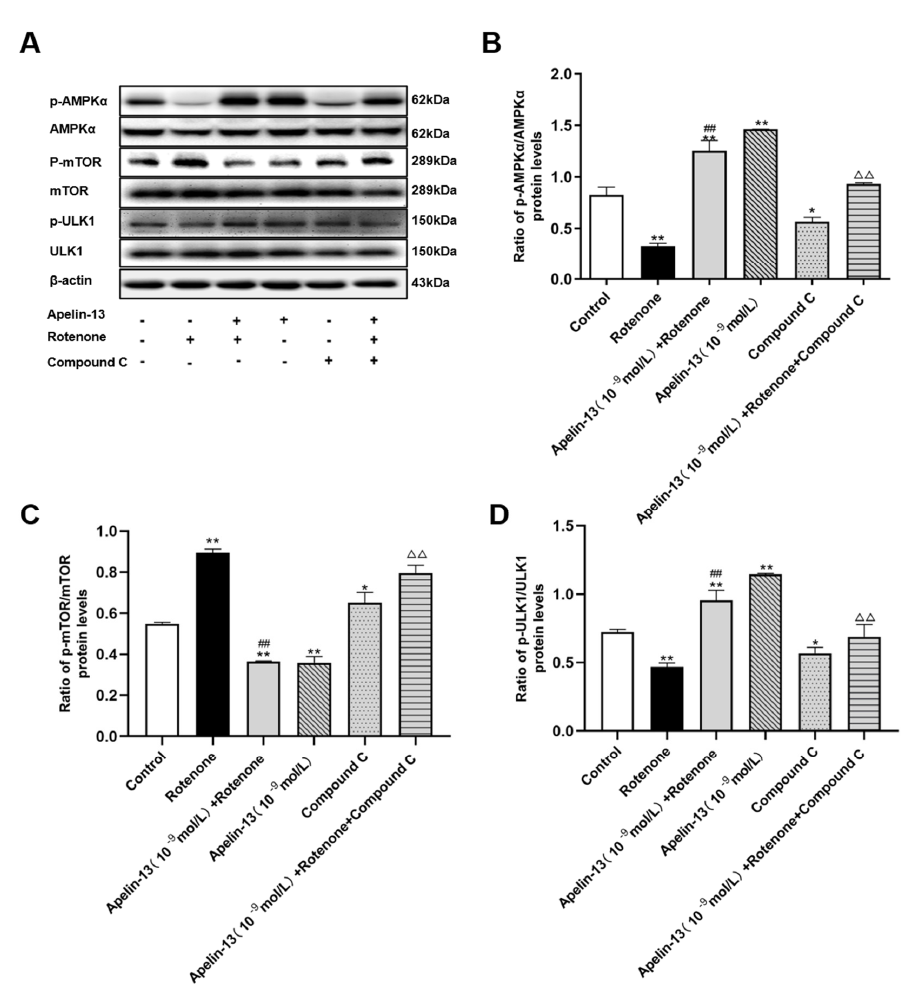
Figure 7. E ff ects of compound C on the AMPK / mTOR / ULK1 signaling pathway in SH-SY5Y cells with rotenone and apelin-13 treatment. SH-SY5Y cells were exposed to rotenone with or without apelin-13, or with compound C pretreatment prior to rotenone and apelin-13. ( A – D ) Western blot was applied to detect the phosphorylated and total AMPK α , mTOR, and ULK1. Apelin-13 antagonized